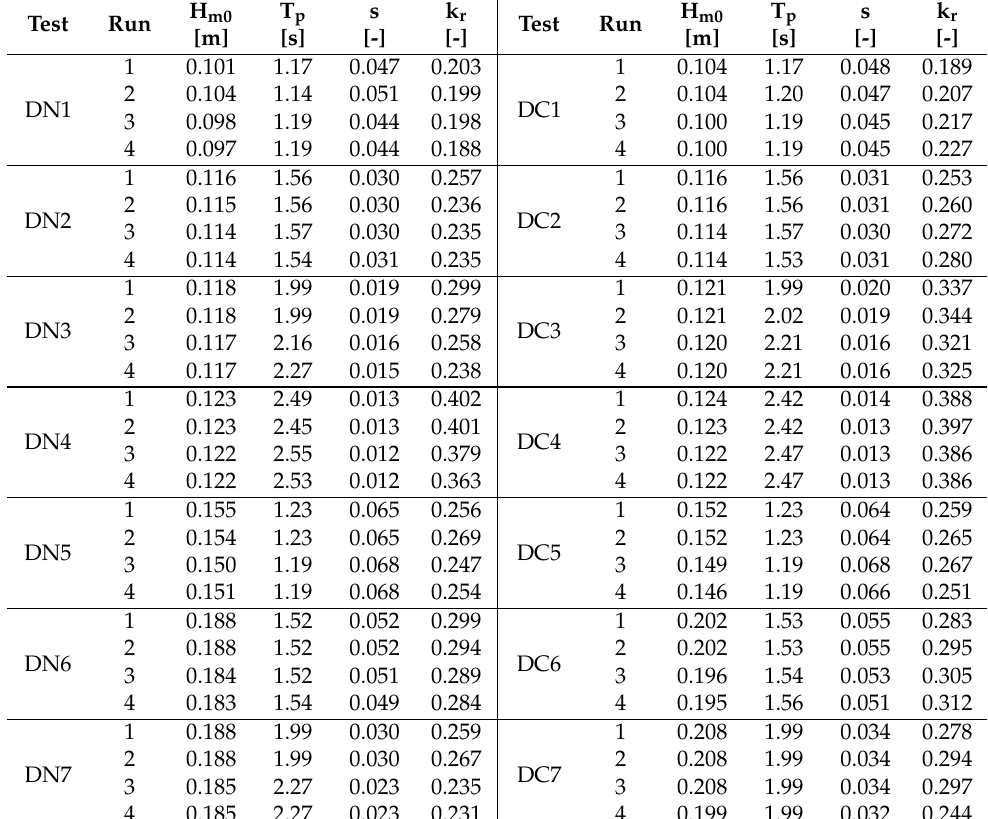
Table 4. Incident irregular wave H m0 , T p , s